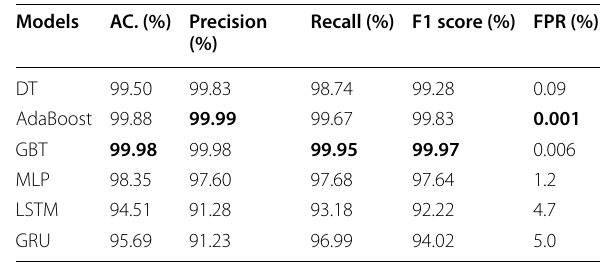
Table 5 Result of the models with all features (42) for UNSW-NB 15 dataset